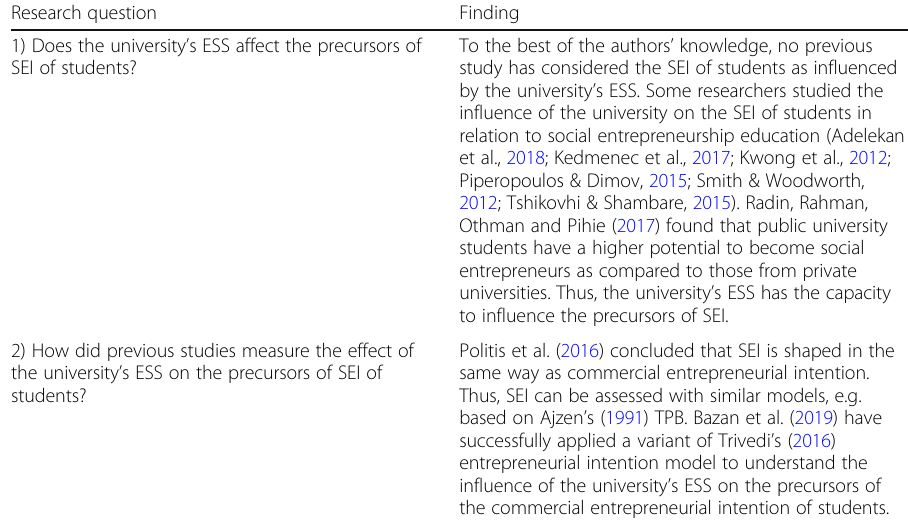
Table 3 Summary of findings as they relate to the research questions Research question